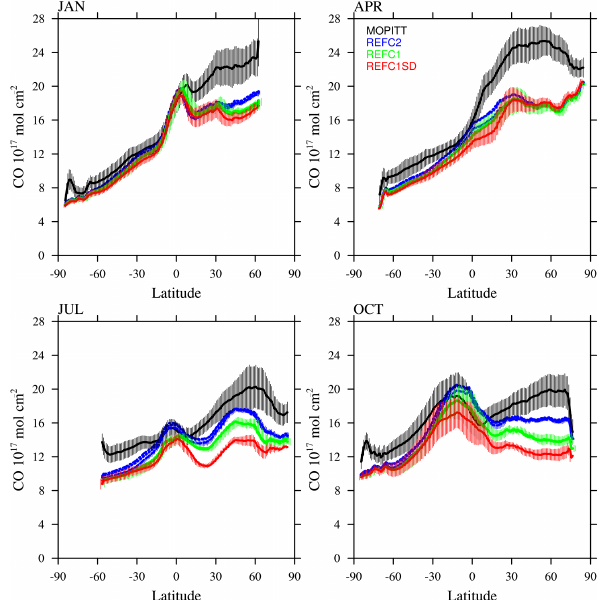
Figure 8. As Fig. 7, but showing monthly and zonally averaged stratospheric ozone column comparison between OMI/MLS obser- vations (black) and different model experiments; see legend (for ozone > 150ppb in the model) for 4 months.